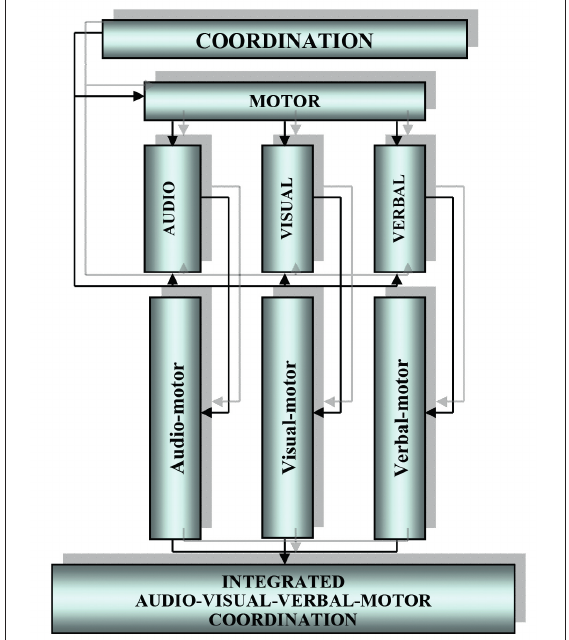
Figure 1. Types of complex coordination (Gönczi-Raicu, Aftimiciuc, & Danail , 2014)